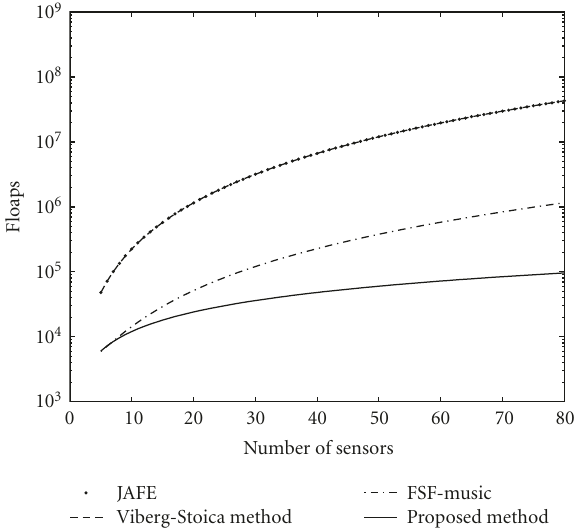
Figure 12: Main computational complexity of various algorithms versus the number of sensors with fixed K = 4, N = 100, and P = 3.